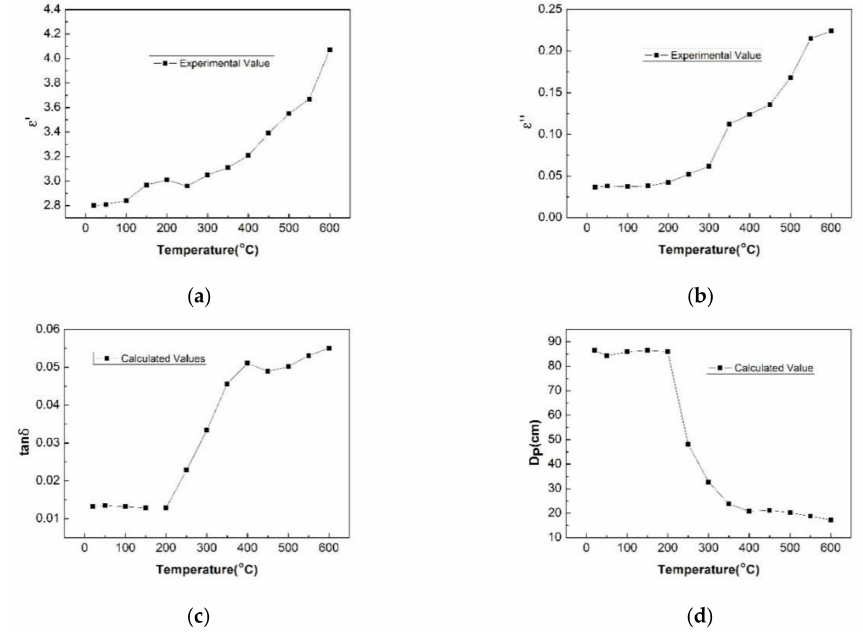
Figure 5. Relative dielectric properties of the dried NCS at di ff erent temperatures. ( a ) Relative dielectric constant ( ε (cid:48) ), ( b ) relative loss factor ( ε ”), ( c ) dielectric loss angle tangent (tan δ ), and ( d ) power penetration